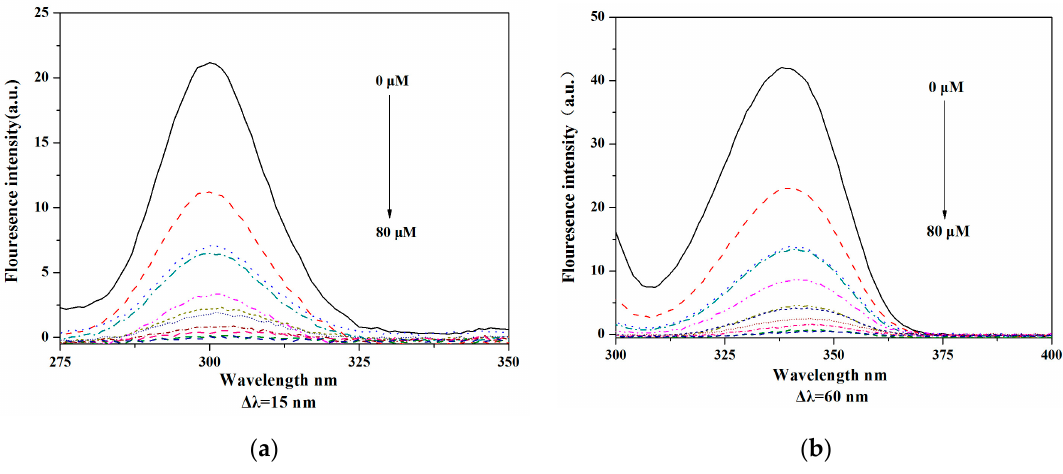
Figure 12. The synchronous fluorescence spectra of HSA (2 μ M) in the presence of different concentrations of V 18 (0, 8, 16, 24, 32, 40, 48, 56, 64, 72, 80 μ M): ( a ) Δλ = 15 nm and ( b ) Δλ = 60 nm at 20 °C in PBS.